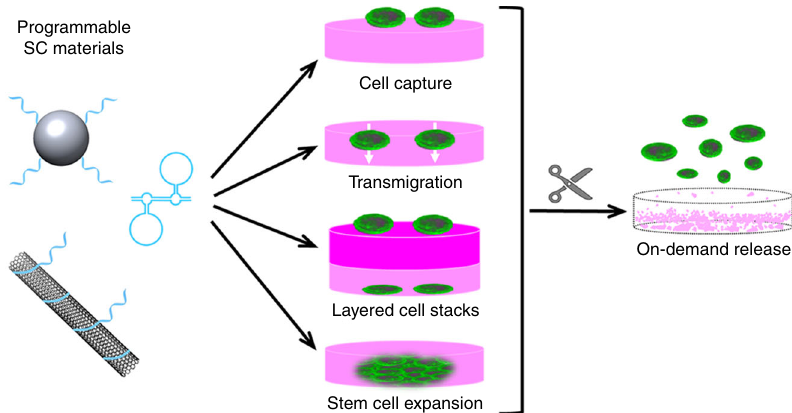
Fig. 1 Strategy. The mechanical properties of SiNP/CNT-DNA composites can be adjusted by enzymatic polymerization of DNA-modi fi ed nanoparticles. The utility of the resulting “ SC materials ” for cell-substrate engineering is demonstrated by control of cellular adhesion, proliferation, lateral, and vertical motility, as well as by expansion and release of embryonic stem cells by simpli fi